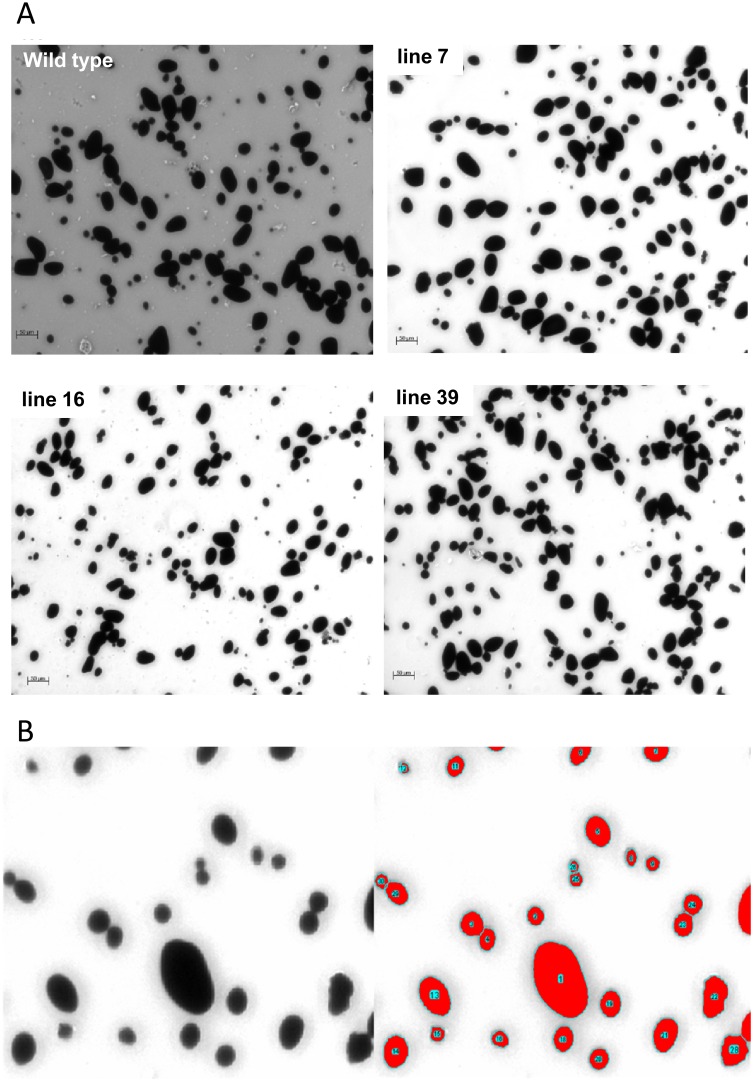
Determination of the starch granule size.Starch granules from freshly harvested tubers were extracted, stained with iodine and inspected under the microscope. A) representative micrographs of iodine-stained starch granules derived from tubers of wild-type and ISA-silenced lines 7, 16 and 39. B) Representative image illustrating the segmentation of images by means of the ImageJ software tool to determine the relative size of each 2D starch granule. The software allows for the manual separation of granules connected to each other in the image.